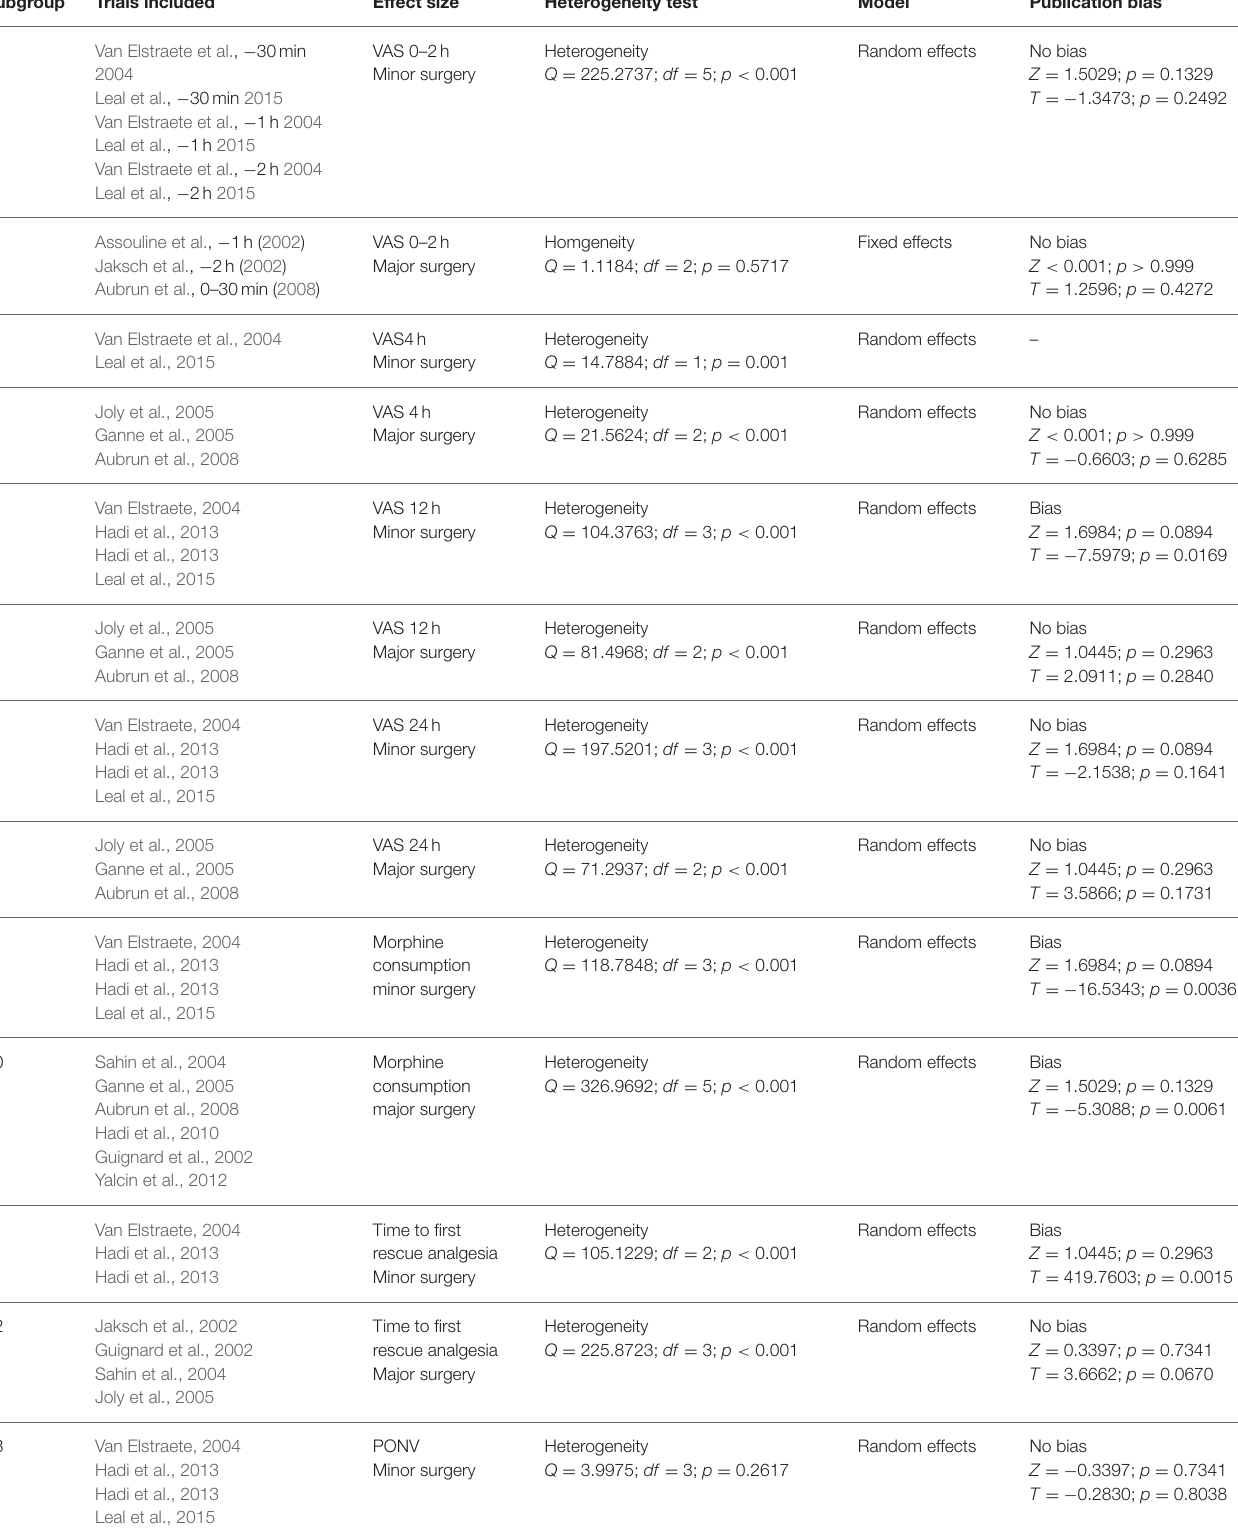
TABLE 3 | Characteristics of subgroups included in the meta-analysis.